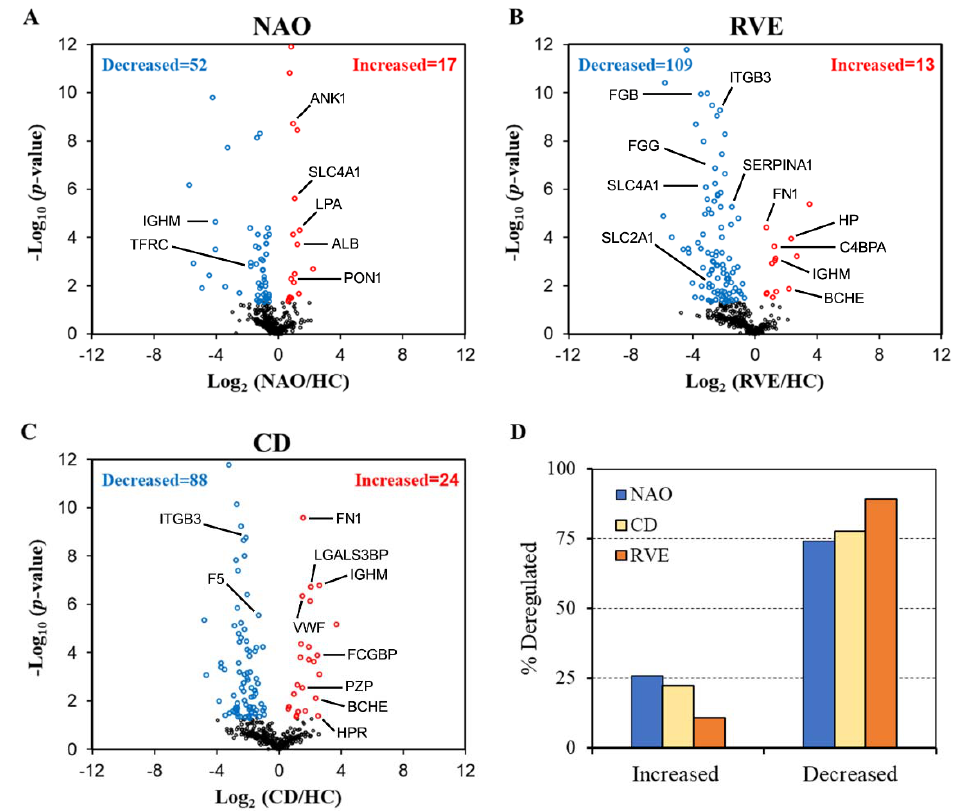
Figure 2. Volcano plot of quantified proteins in three different LACI groups: ( A ) NAO, ( B ) RVE, and ( C ) CD, when compared to HC. The iTRAQ ratios obtained from database searching in ProteinPilot software were log-transformed and plotted against the negative log of the p -value for respective ratios. Blue dots indicate decreased and red dots indicate increased proteins satisfying the two filtering criteria; p < 0.05 and fold change = 1.5 (|Log 2 (ratio)|> 0.58 and ( − log 10 ( p -value)) > 1.30). The black dots represent unchanged proteins. Some of the shortlisted proteins from Table 1 are labeled. The plots are presented with an axis value of − 12.0 to +12.0 for better visualization. ( D ) Bar chart showing the percentage of proteins increased and decreased in three different LACI groups (NAO, RVE, and CD). NAO, no adverse outcome; RVE, recurrent vascular event; CD, cognitive decline; HC, healthy control.